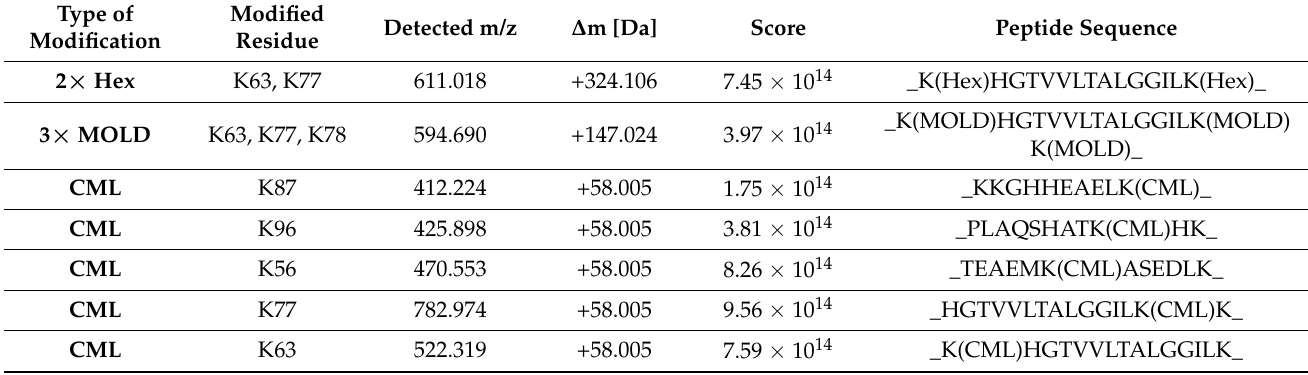
Table 2. Glycation adducts identified in MB-mel formed during glycation in dry conditions